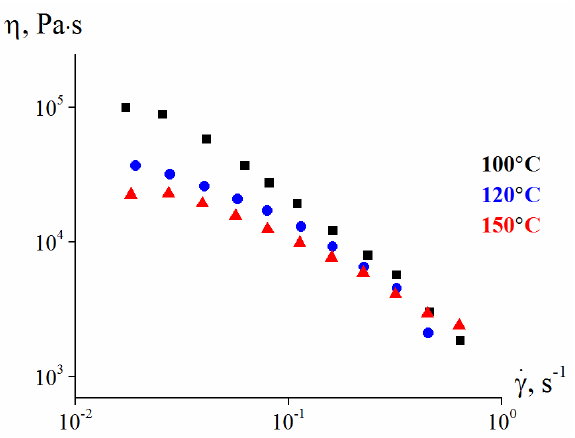
Figure 11. Flow curves of the molding composition at different temperatures.